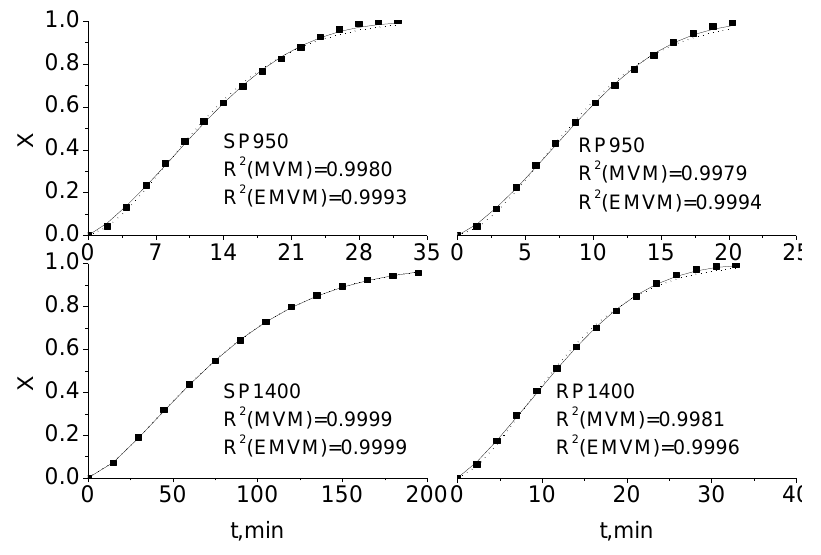
Figure 5. Carbon conversions versus gasification time for coal char gasification at the gasification temperature of 950 °C. Experimental data( ■ ); MVM (  ); EMVM (—).